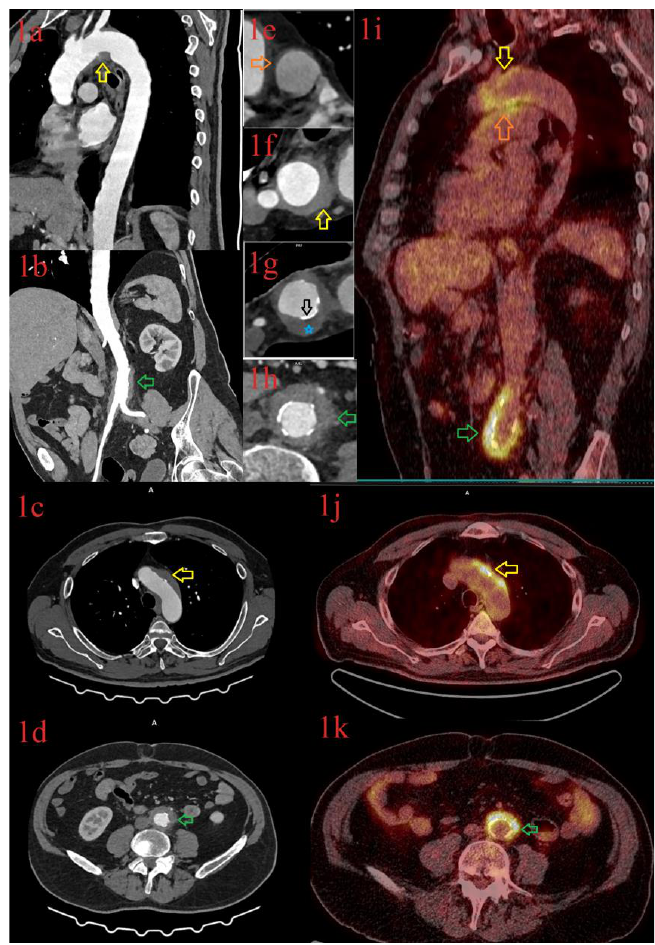
Figure 4. CT angiography (Images ( 1a – 1h )) and Whole-body FDG PET-CT (Images ( 1i – 1k )) in a 68-year-old male patient with large-vessel vasculitis showing vessel inflammation with asymmetric hypodense wall thickening (Image ( 1g ), blue star) and intimal calcification (Image ( 1g ), black arrow) and avid FDG uptake at the same level on the following localizations: the aortic arch (CT: Image ( 1a , 1c , 1f ); PET-CT: Image ( 1i ) I ( 1j ); yellow arrows), pulmonary trunk (CT: Image ( 1e ), PET-CT: Image ( 1i ); orange arrows), and the abdominal aorta (CT: Image ( 1b , 1d , 1h ); PET-CT: Image ( 1i ) I ( 1k ), green arrows).